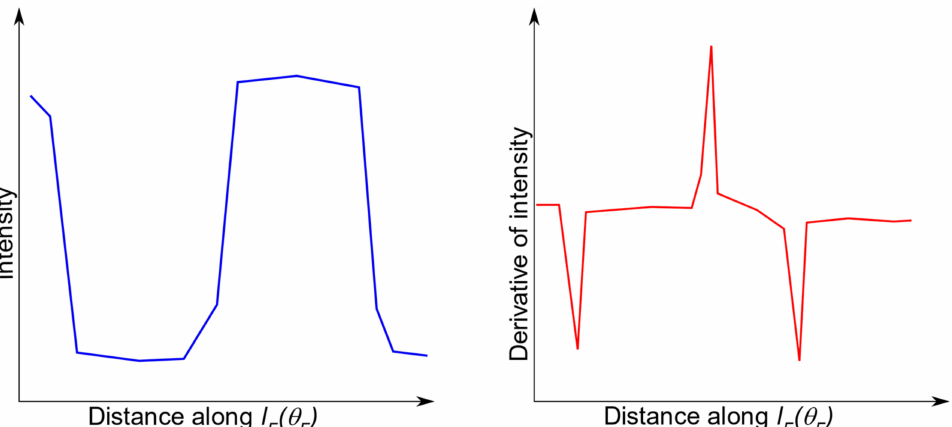
Figure 8. Expected line profile ( left image) and its first derivative ( right image). The distance coordinate starts at PTMJa, the line passes the border between bone and soft tissue three times: leaving the acetabulum (first derivative peak, negative), entering the TMJ head (second derivative peak, positive), and leaving the TMJ head (third derivative peak,